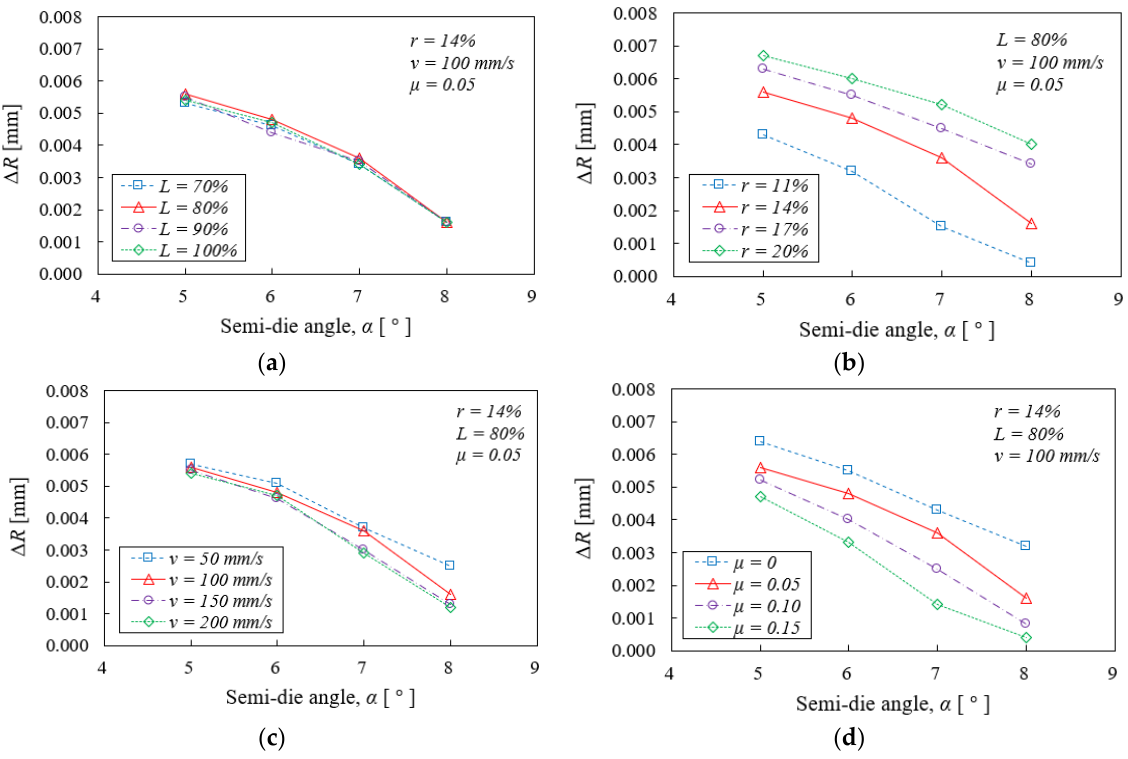
Figure 6. Effects of semi-die angle on ∆ R under different conditions. ( a ) Different bearing ratios; ( b ) different reduction ratios; ( c ) different drawing speeds; ( d ) different friction